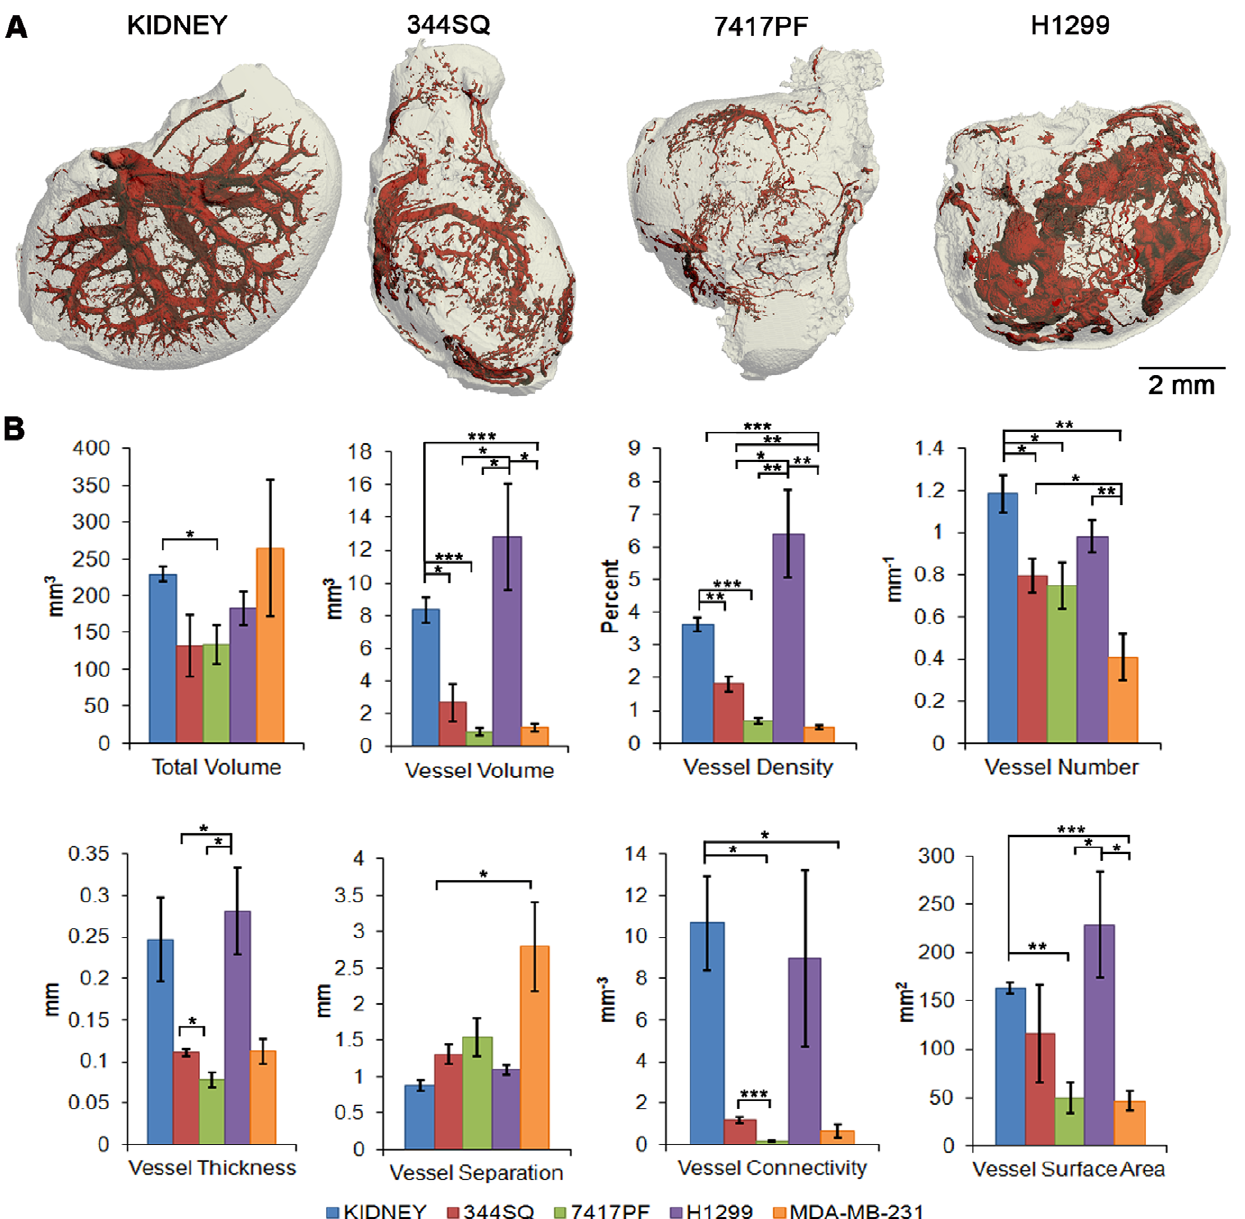
Figure 2. 3-D renderings and quantification of tumor vasculature. ( A ) 3-D micro-CT surface renderings of a Microfil-perfused kidney (left) and three subcutaneous tumors derived from NSCLC cell lines: 344SQ (2 nd from left), 7417PF (3 rd from left) and H1299 (right). The entire tissue or tumor mass is in gray, and the vasculature in red. Using this imaging analysis in combination with 3-D measurement techniques, voxel-counting and maximal spheres analysis, two murine NSCLC cell lines (344SQ and 7417PF), and two human cell lines (the NSCLC cell line H1299 and the breast cancer line, MDA-MB-231) were examined. For comparison purposes, the kidney, being similar in size to the subcutaneous tumors, was also examined. ( B ) Quantification yielded representative average measurements for total volume (TV), vessel volume (VV), vessel density (VV/TV), vessel number (V.N), vessel thickness (V.Th), vessel separation (V.Sp), vessel connectivity or branching (V.ConnD), and vessel surface area (V.SA). Data are shown as the average 6 s.e.m. (N=3–6 per cell line). All of the cell lines (apart from H1299) demonstrated significant variability in vessel parameters compared with the kidney. Asterisks indicate: * p , 0.05, ** p , 0.01, *** p , 0.001. doi:10.1371/journal.pone.0041685.g002 While the measurements described above allow for 3-D diameter ranges for both vessel thickness (V.Th) and vessel separation (V.Sp) (measuring the thickness of the tumor tissue quantification of vascular parameters, these measurements are restricted to an average of the vasculature across an entire tumor, lying between vessels), a novel use of this method and a means of and cannot extrapolate changes happening in one area of a tumor quantifying avascular regions within a tumor. By applying the data over another. Using the maximal sphere-filling model [22,23], over a histogram, we can clearly see the sphere diameter ranges that are present within a given tumor. however, we can calculate the volume of spheres at increasing